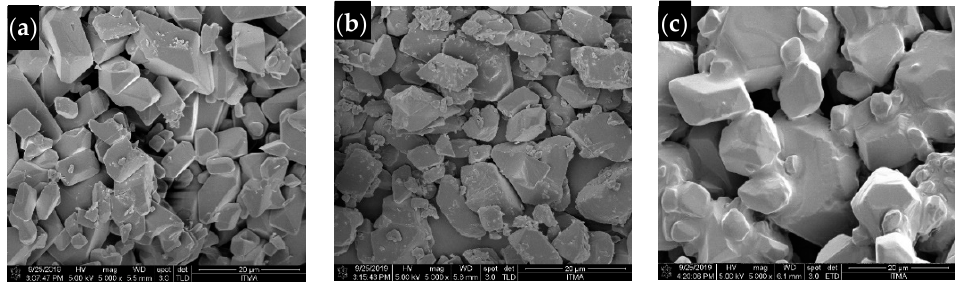
Figure 6. Field emission scanning electron micrographs of ( a ) HMBS, ( b ) HMDS and ( c ) HMT under 5000× magnifications.